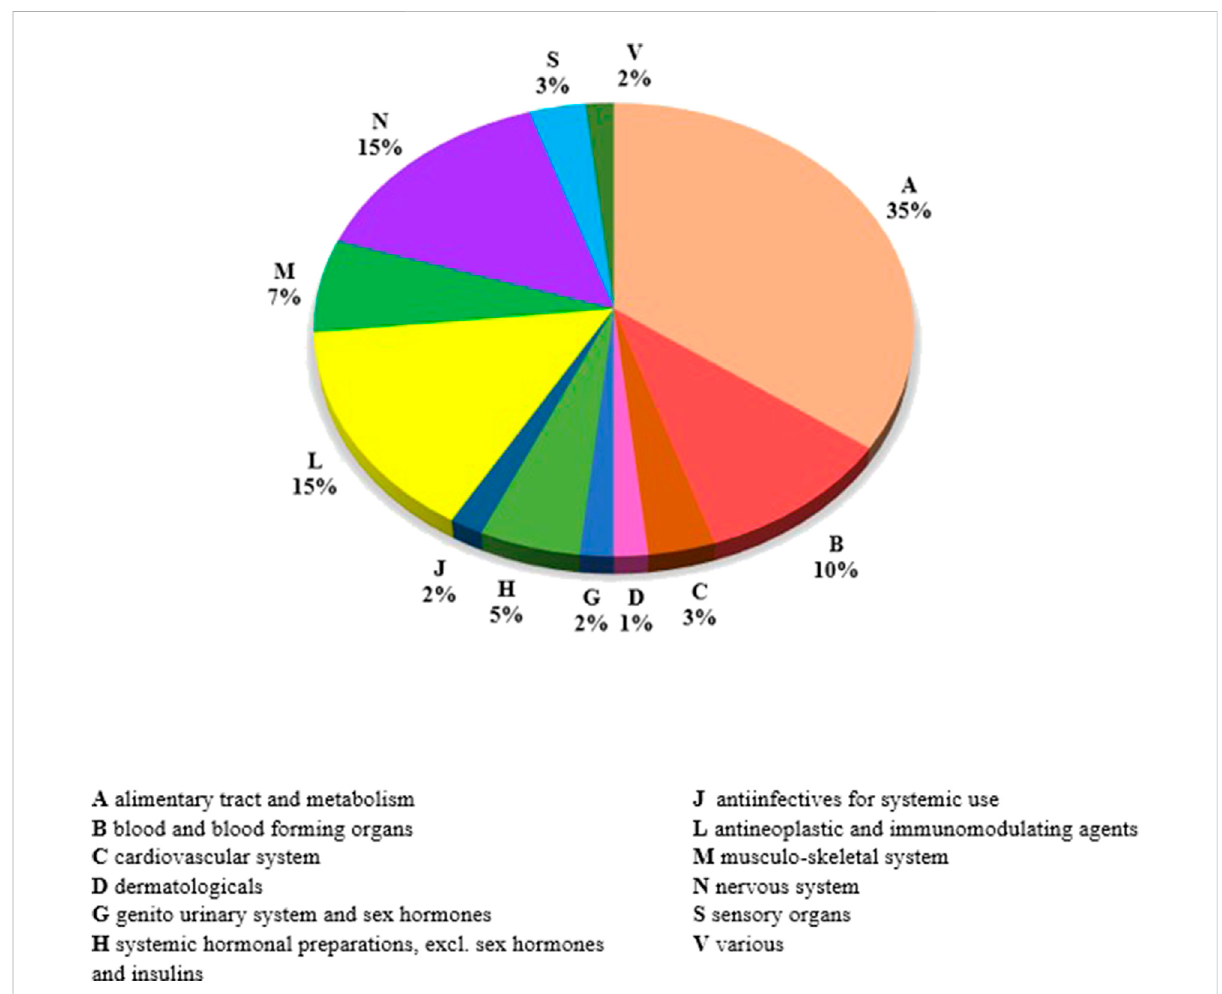
FIGURE 1 Distribution of medicinal products of the OMP list per fi rst level of ATC classi fi